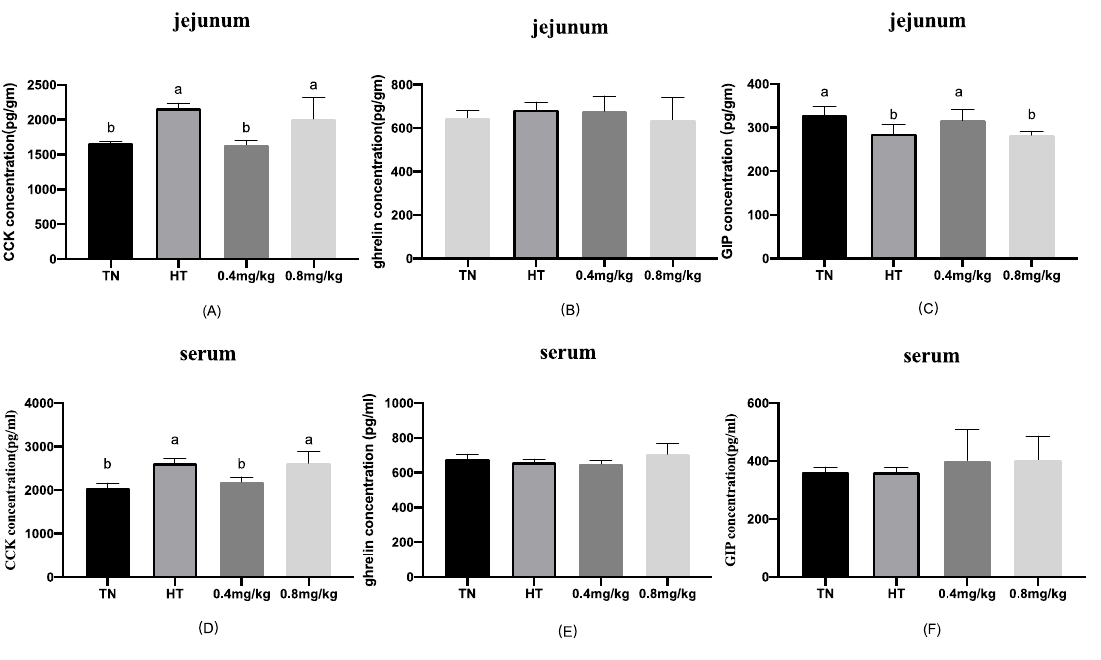
Figure 2. Effects of chromium supplementation on gastrointestinal peptides in the jejunum and serum. ( A ) CCK concentration in the jejunum; ( B ) ghrelin concentration in the jejunum; ( C ) GIP concentration in the jejunum; ( D ) CCK concentration in the serum; ( E ) ghrelin concentration in the serum; ( F ) GIP concentration in the serum. a,b Means values between the column with different letters differ significantly.